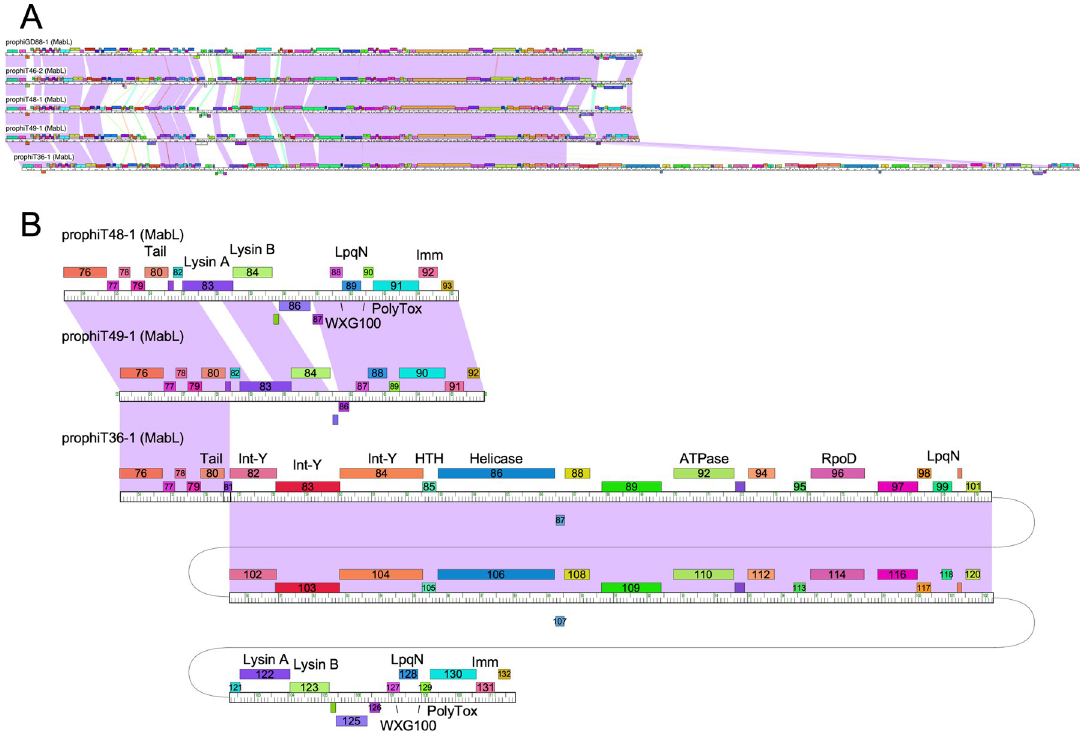
Fig 5. A large insertion in prophiT36-1. A . ProphiT36-1 is a member of Cluster MabL and is closely related to other cluster members. Five Cluster MabL genomes are shown and displayed in a phamerator genome map as in Fig 3. ProphiT36-1 is the 110, 792 bp genome at the bottom where the large insertion near the right end is evident. The alignment illustrates the global relationships, without emphasis on genomic details. B . The tandemly inserted 22.5 kbp DNA segment in prophiT36-1. The extreme right end of prophiT36-1 is shown aligned with prophiT48-1 and prophiT49-1. The insertion in prophT36-1 has been ‘wrapped’ such as to align the two repeated segments, which are identical to each other. Genomes are presented as in panel A, but with gene numbers shown with each gene box and putative functions indicated where known. Rightwards- and leftwards-transcribed genes are shown above and below genomes tracks, respectively. Note that the prophiT36-1 segment from genes 121 to 132 is closely related at the nucleotide level to prophiT48-1 genes 76 – 93